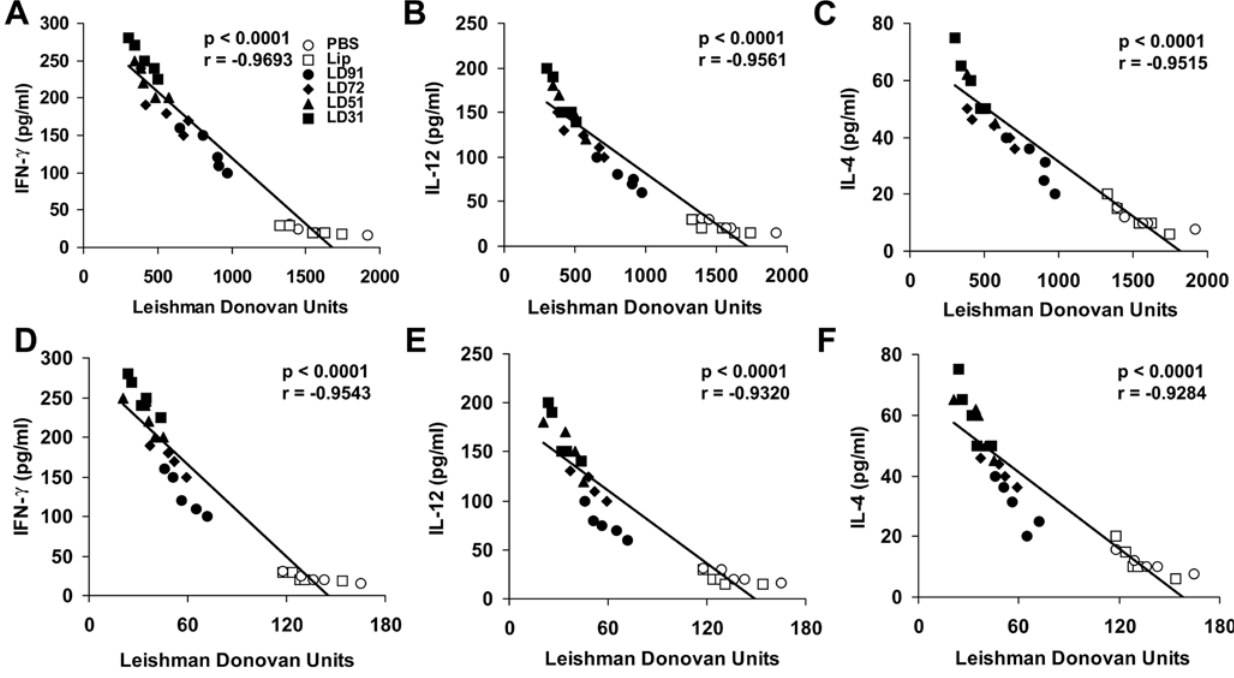
Figure 6. Correlates of immune responses and reduced parasite burdens in BALB/c mice vaccinated with cationic liposomal antigens. Liver and spleen parasite burden after 3 months challenge infection with L. donovani promastigotes was tested for correlation with antigen-specific prechallenge IFN- c , IL-12 and IL-4 responses. Magnitudes of the antigen-specific IFN- c , IL-12 and IL-4 production were inversely correlated with the liver (A to C) and spleen (D to F) parasite burdens. Each symbol represents an individual animal from a vaccinated group. The p- values were calculated for correlation efficiency and were considered significant at p , 0.05. Spearman’s rank correlation coefficient values are represented (r). Diagonal lines represent linear